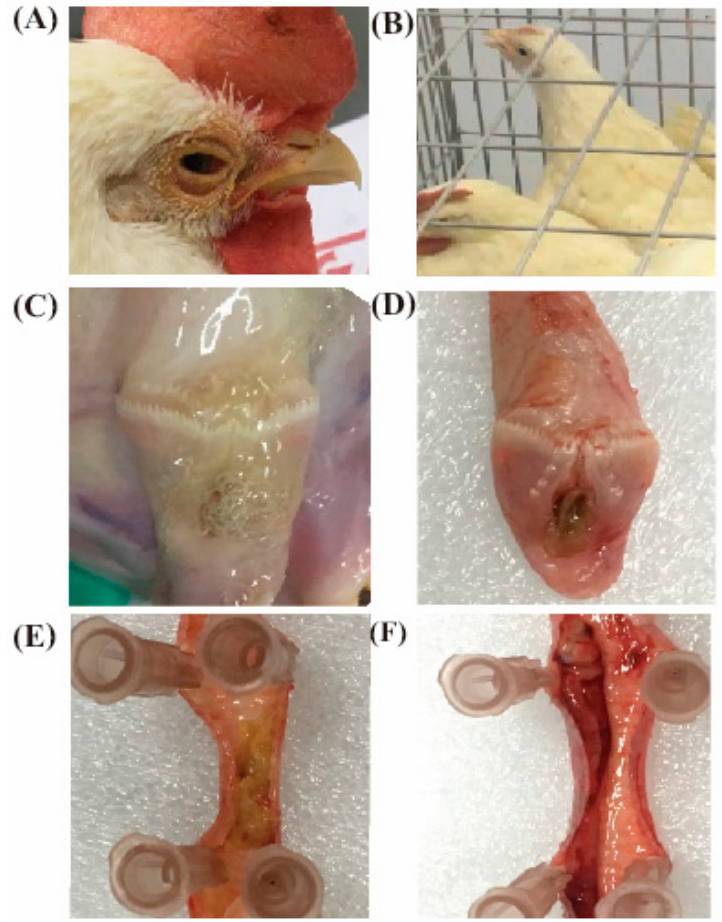
Figure 5. Clinical symptoms and throat tracheal lesions of chickens after challenge. ( A ) Serious conjunctivitis, ( B ) dyspnea, ( C ) mucus in the mouth and throat, ( D – F ) larynx and trachea with embolism of inflammatory exudate, bloody exudate, and hemorrhagic points.